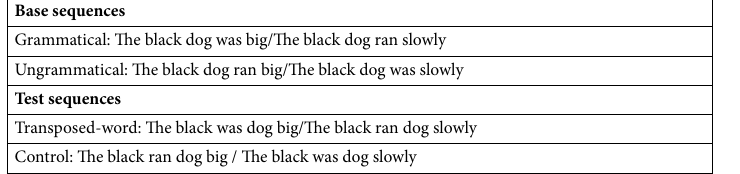
Table 1. English examples illustrating how the critical ungrammatical test sequences used in the Experiment were constructed from quadruplets of base sequences of five words that could either form a correct sentence (grammatical) or not (ungrammatical). Examples are in English for convenience, whereas the experiment was in